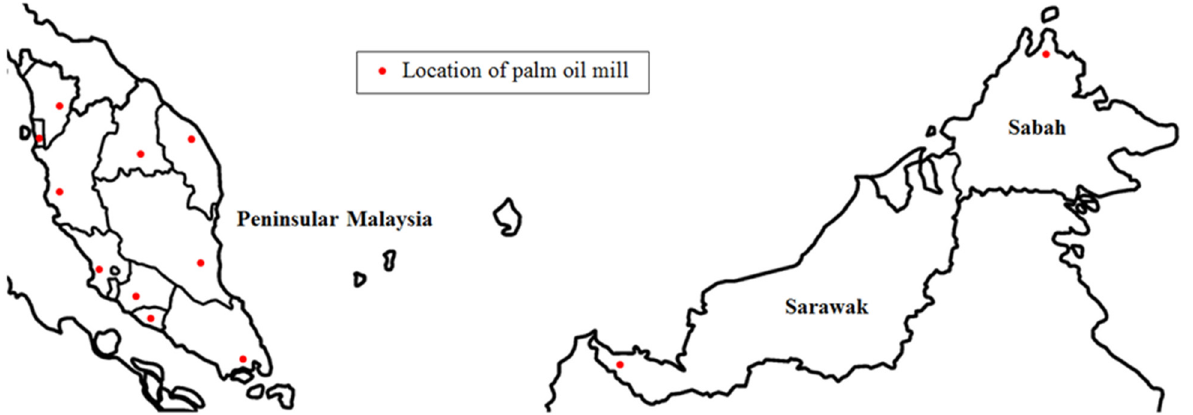
Figure 3. Location of palm oil mills selected for POC sampling in Malaysia (Map from www.Mapsof.net).